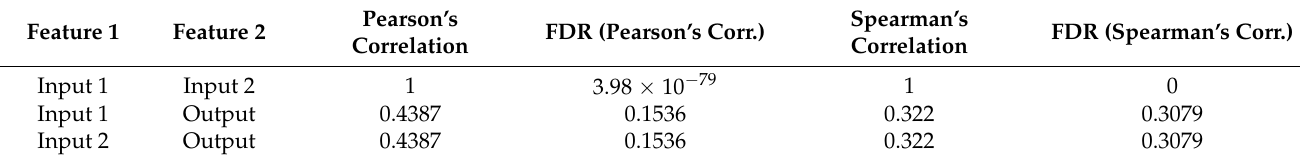
Table 3. Correlation between variables.